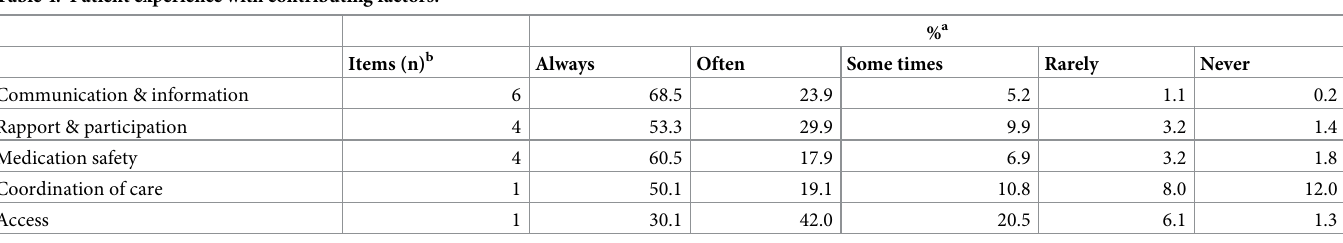
Table 4. Patient experience with contributing factors.